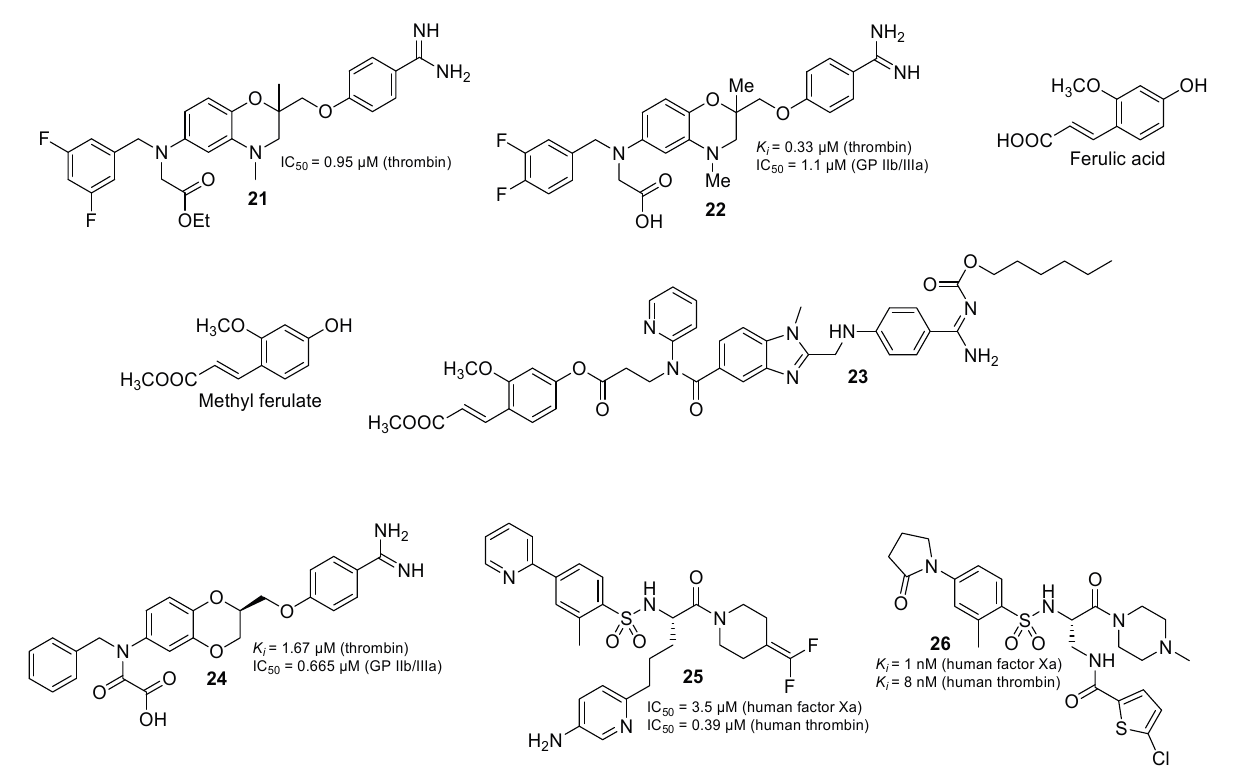
Figure 5. The chemical structures of thrombin inhibitor in multi-target